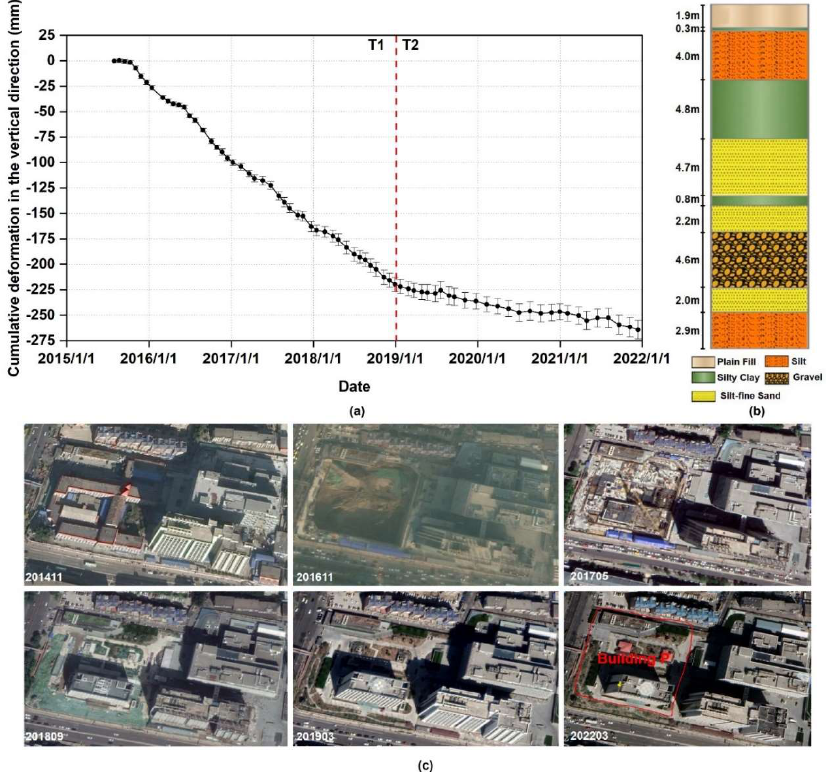
Figure 14. Cumulative deformation ( a ) and the geological drilling information of Building P ( b ), and ( c ) several typical enlarged optical remote sensing images obtained from Google earth of Building P.